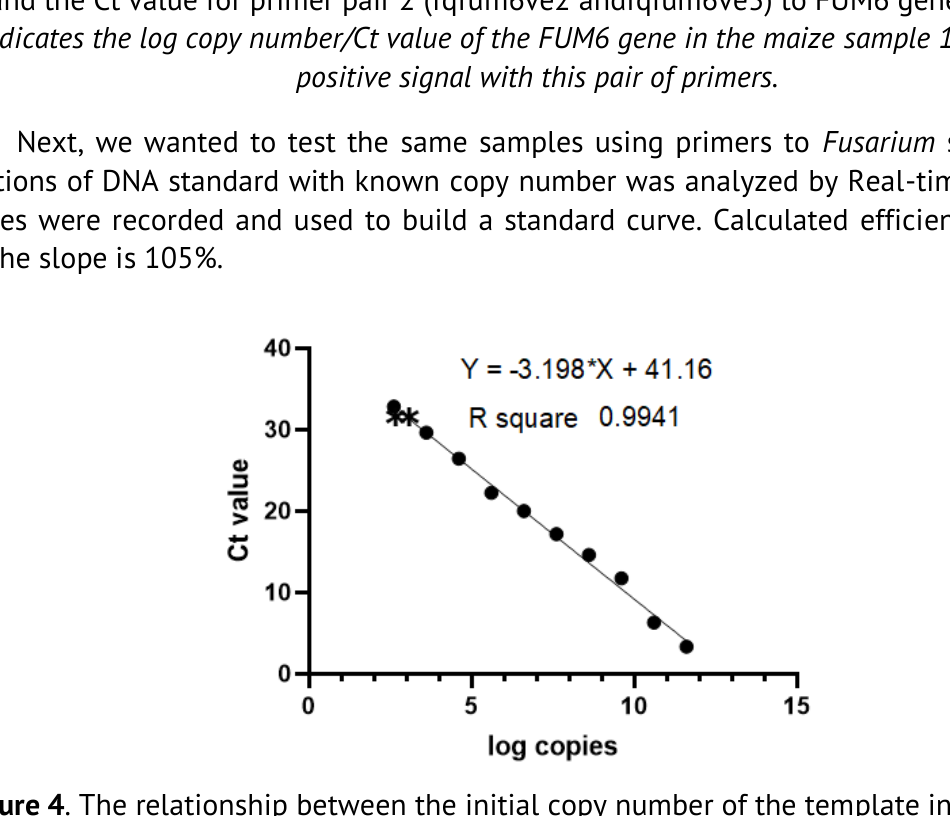
Figure 4 . The relationship between the initial copy number of the template in the reaction and the Ct value for primer pair 4(fcbt2 and fcbt3) to Fusarium beta-tubulin gene. *The asterisks indicate the log copy number/Ct value of the fusarium beta-tubulin gene in the maize samples 1 and 2 which gave positive signal with this pair of